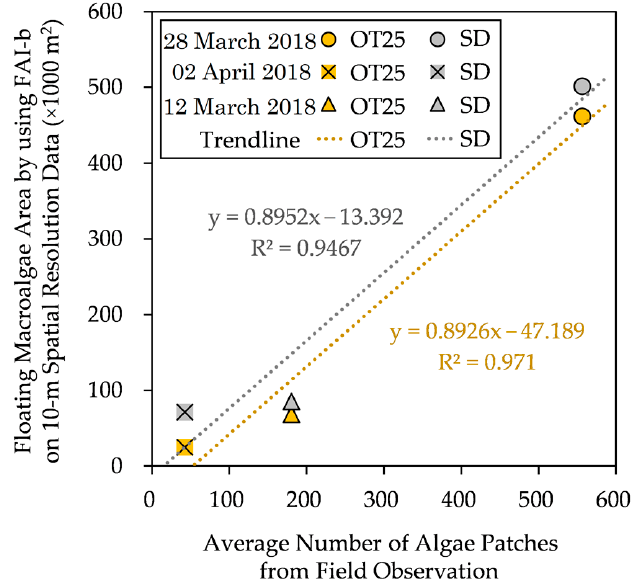
Figure 9. Floating macroalgae area estimated using FAI-b on 10 m spatial-resolution data vs. average number of macroalgae patches from field observation data [3]. The details of these methods are found in the main text.